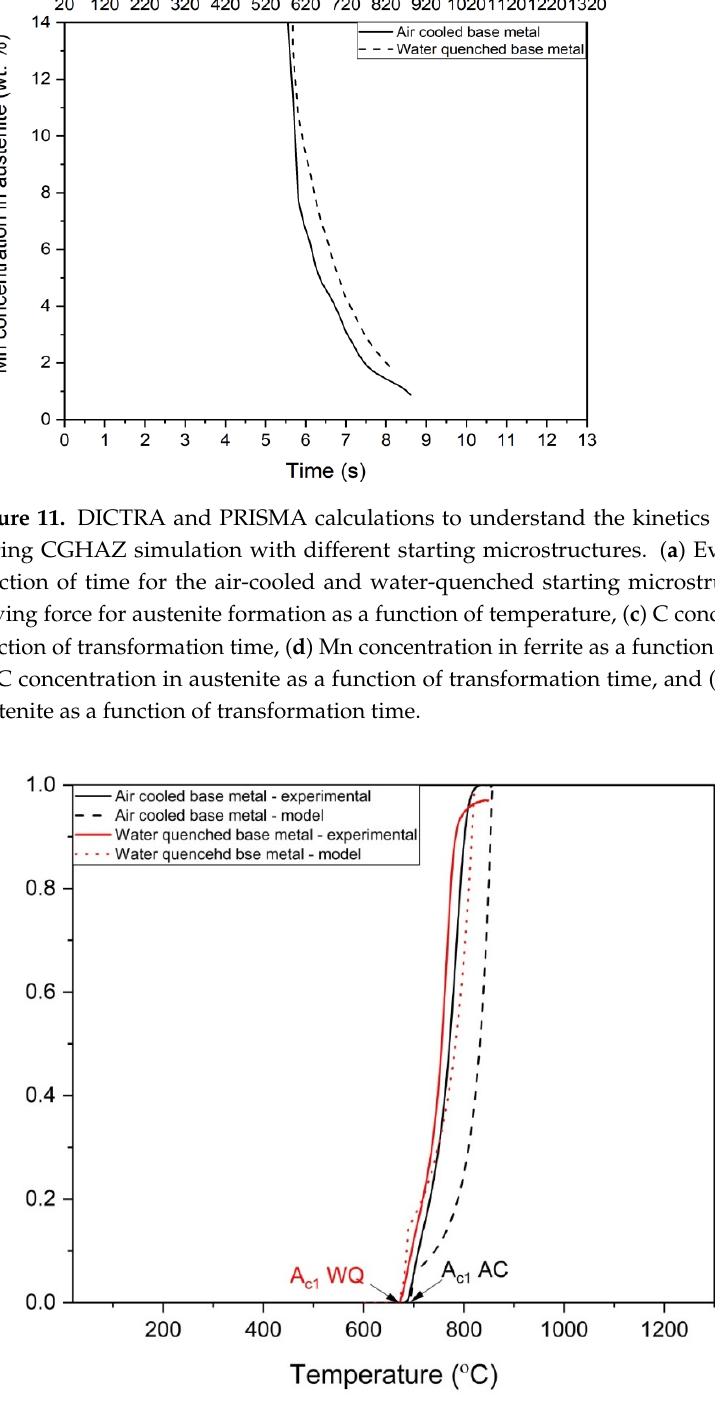
Figure 12. Comparison between experimental austenite formation and model predicted austenite formation.